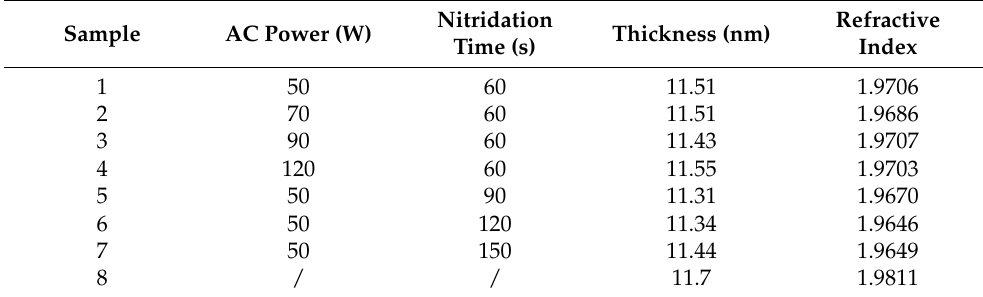
Table 1. The eight deposition conditions of PVD AlN films. The thicknesses and the refractive indices belong to the films on the flat (without patterns) c-plane sapphire substrates tested by